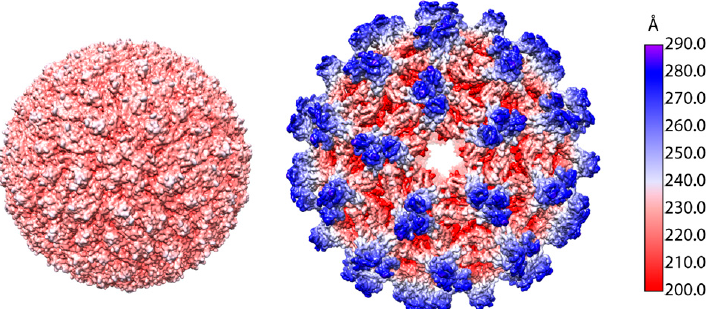
Figure 7. Surface view of the mature and the immature DENV particles (wwPDB: 3J27 and 4B03, respectively) coloured radially according to the key. Only the prM and E models are included, the membrane and nucleocapsid inside the immature particle is not visible, leading to apparent ‘holes’ on the five-fold axis of symmetry.